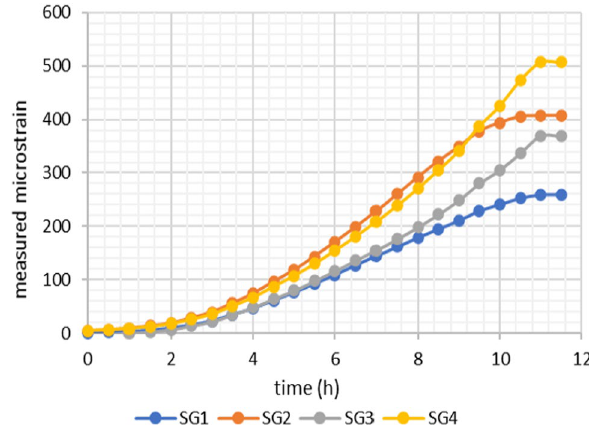
0 b Initial breakage